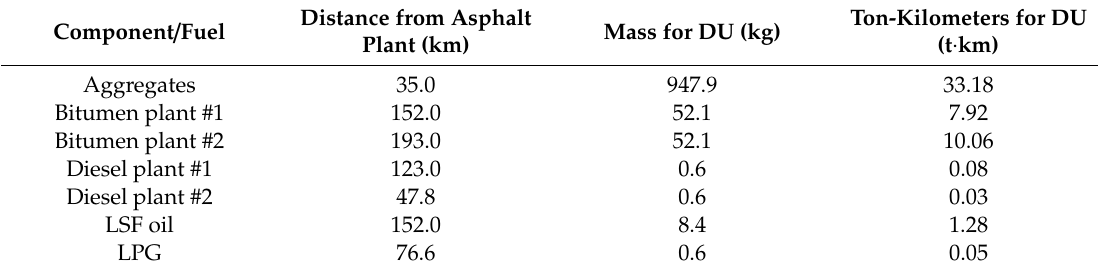
Table 7. Component and fuel production site distance from asphalt plant (km) and ton-kilometer